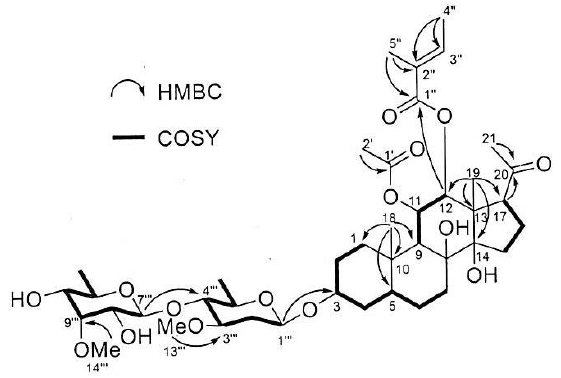
Figure 8. COSY and HMBC correlations of compound 1 .